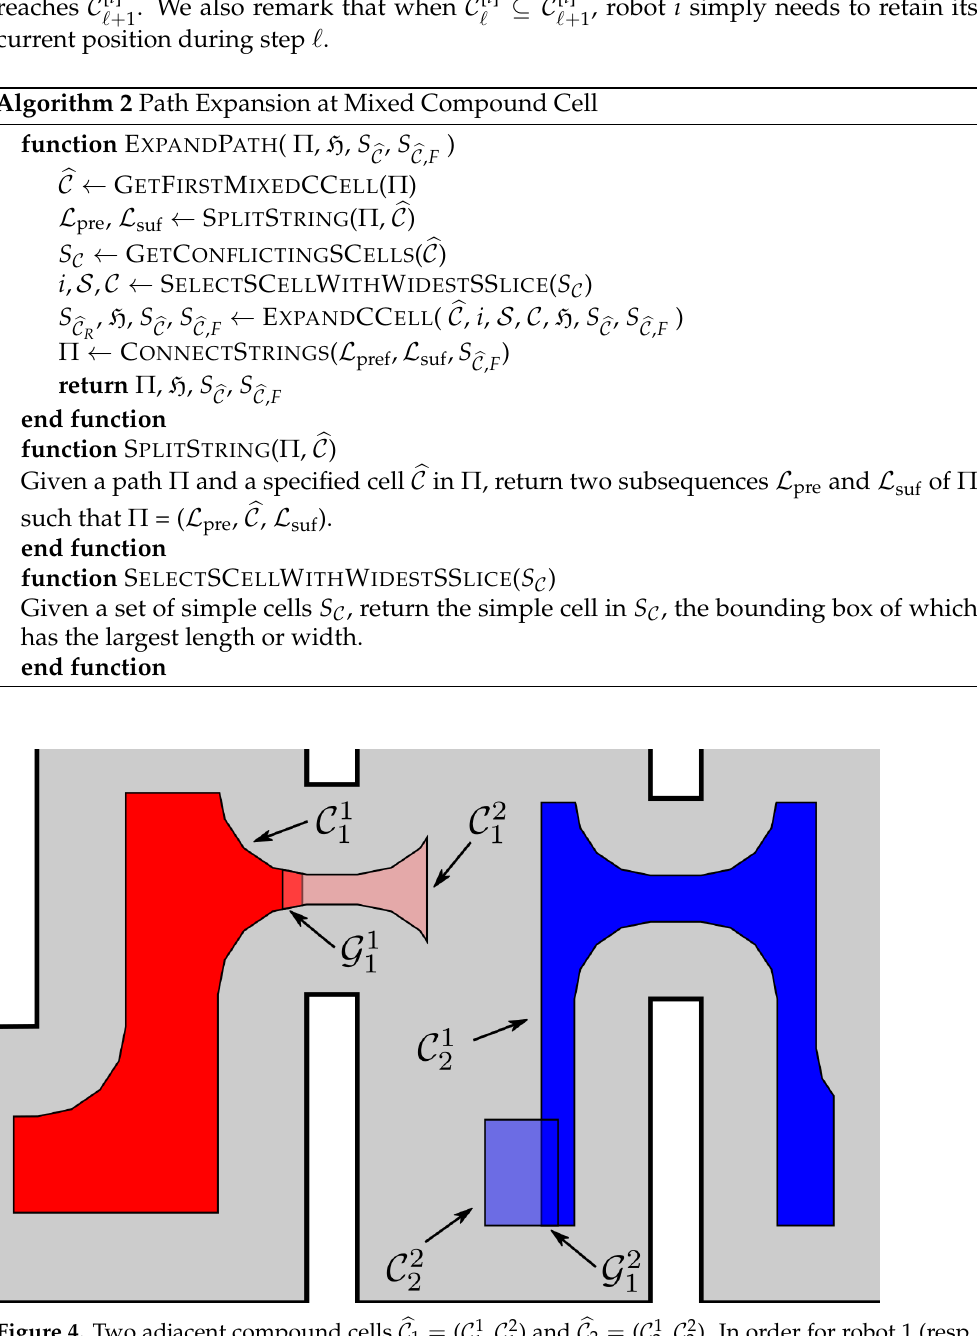
, C 2 ) and (cid:98) C 2 = ( C 1 , C 2 ). In order for robot 1 (resp., 2 2 1 1 to C 1 (resp., from C 2 to C 2 ), it has to reach any point of G 1,1 2 2 1 1